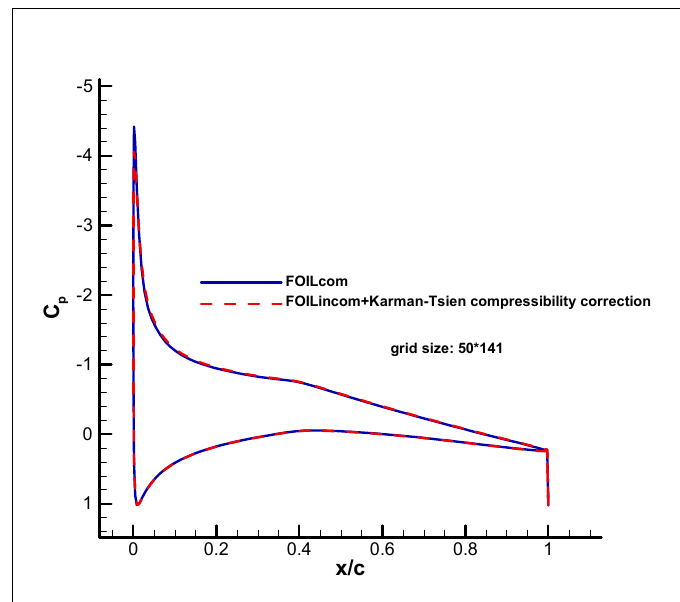
Figure 21. Comparison of surface pressure coefficient distributions for NACA 64-012 airfoil ( M ∞ = 0.3, α = 6 ◦ ) using the codes FOILcom and FOILincom along with the Karman-Tsien compressibility correction.